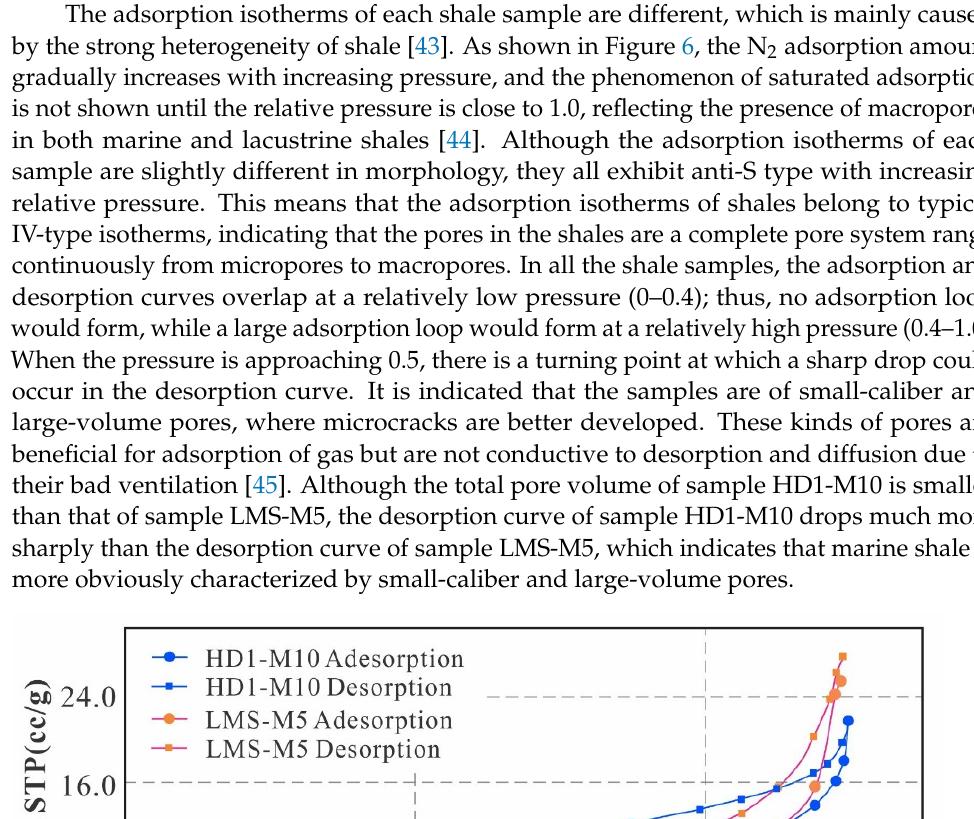
Figure 5. The specific area, total pore volume and mean pore diameter from the N 2 adsorption test results.